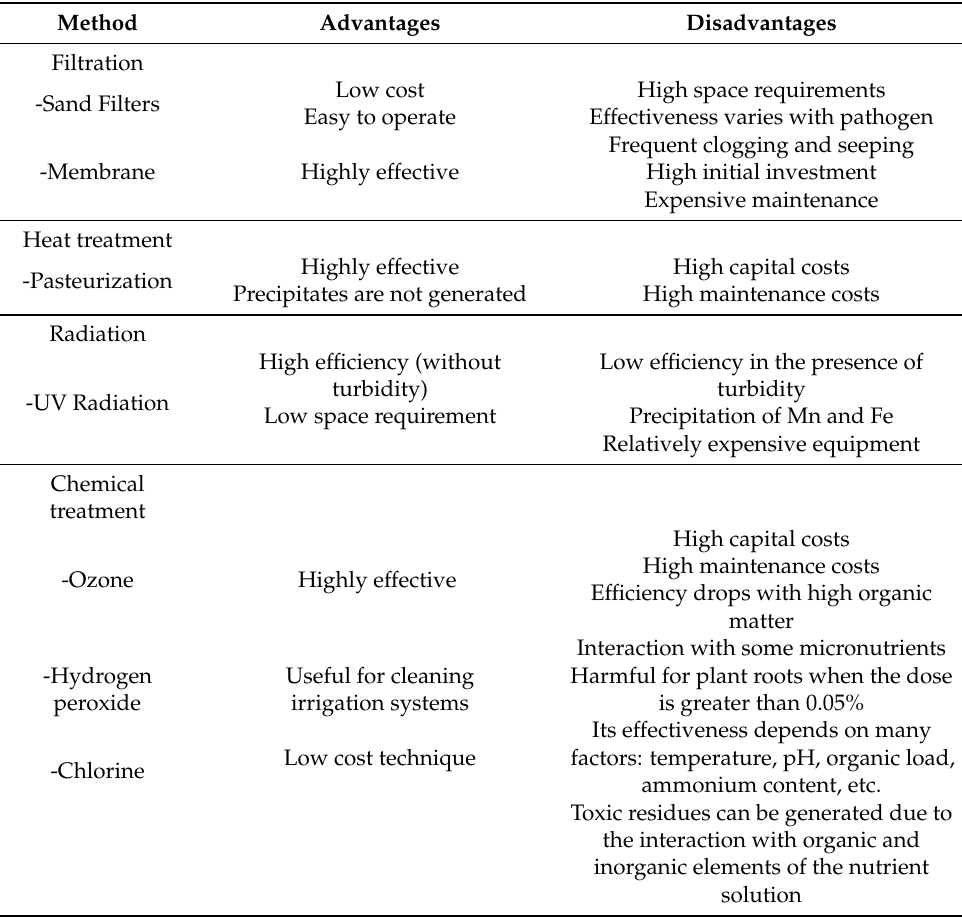
Table 5. Sterilization methods for nutrient solutions: pros and cons